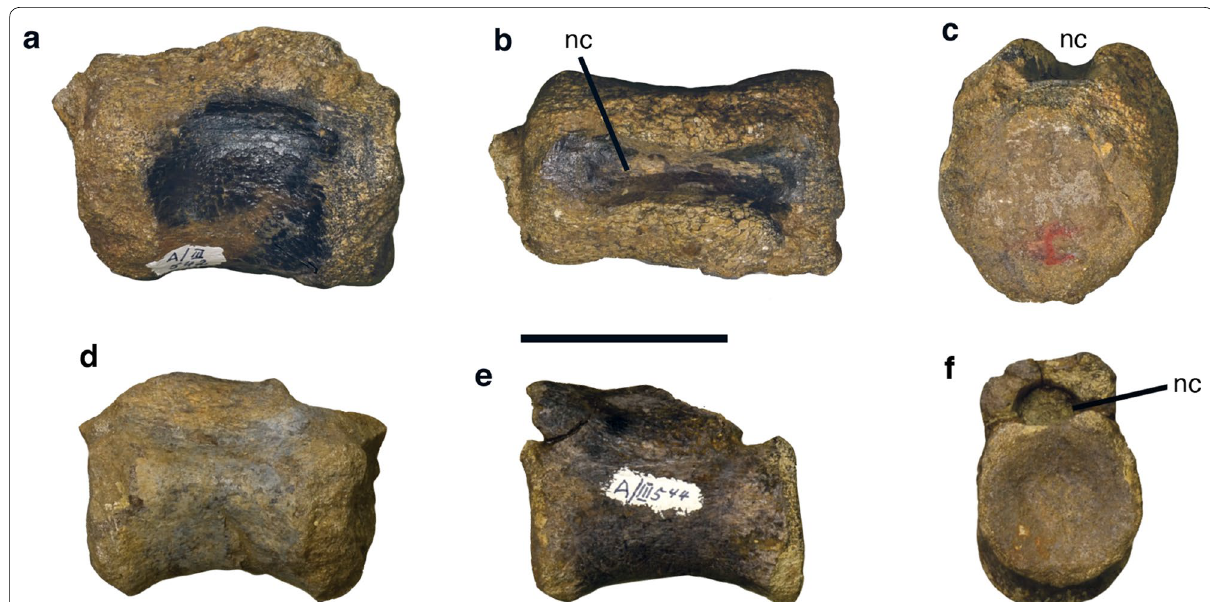
Fig. 7 Middle and distal caudal vertebrae of Schleitheimia schutzi n. gen., n. sp. a – c Middle caudal vertebral centrum, PIMUZ A/III 542, in right lateral ( a ), dorsal ( b ) and anterior ( c ) views; d posterior mid-caudal vertebra, PIMUZ A/III 543, in left lateral view; e , f distal caudal vertebra, PIMUZ A/III 544 in left lateral ( e ) and anterior ( f ) views. nc, neural canal. Scale bar equals 5 cm